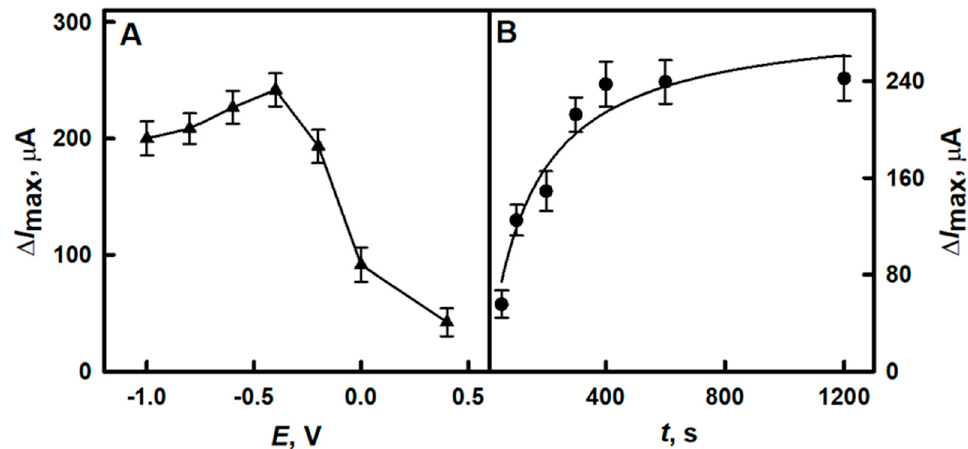
Figure 4. The effect of applied potential ( A ) and the duration ( B ) of electrochemical deposition of DGNs on currents registered by glucose biosensors. ( A ) Electrochemical deposition of DGNs was performed in the solution of 6 mmol L − 1 HAuCl 4 with 0.1 mol L − 1 KNO 3 at different potentials for 400 s; ( B ) Electrochemical deposition of DGNs was performed at constant − 0.4 V potential for different period of time.